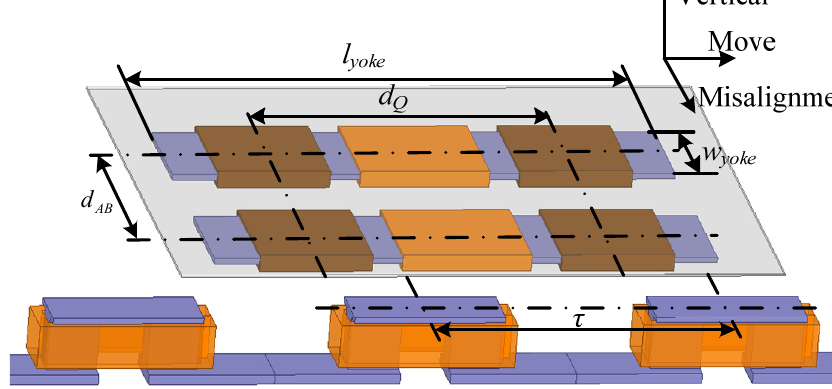
Figure 4. The main structure parameters of the dual-phase NSP receiver.